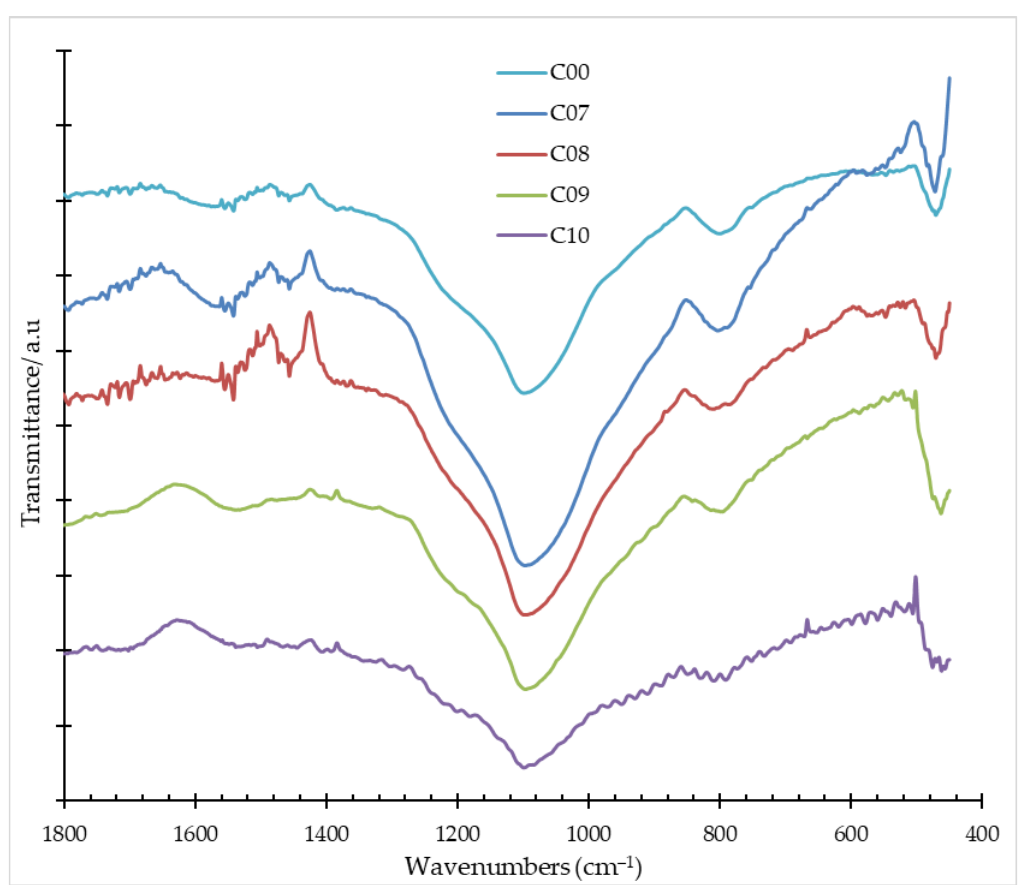
Figure 1. IR spectrum of rice husk char from gasification (C00) and after carbonization at temperature variations of 700, 800, 900, and 1000 °C (C07 – C10). Table 1. Comparison of IR absorption in rice husk char samples from gasification, carbonization with temperature variations, and